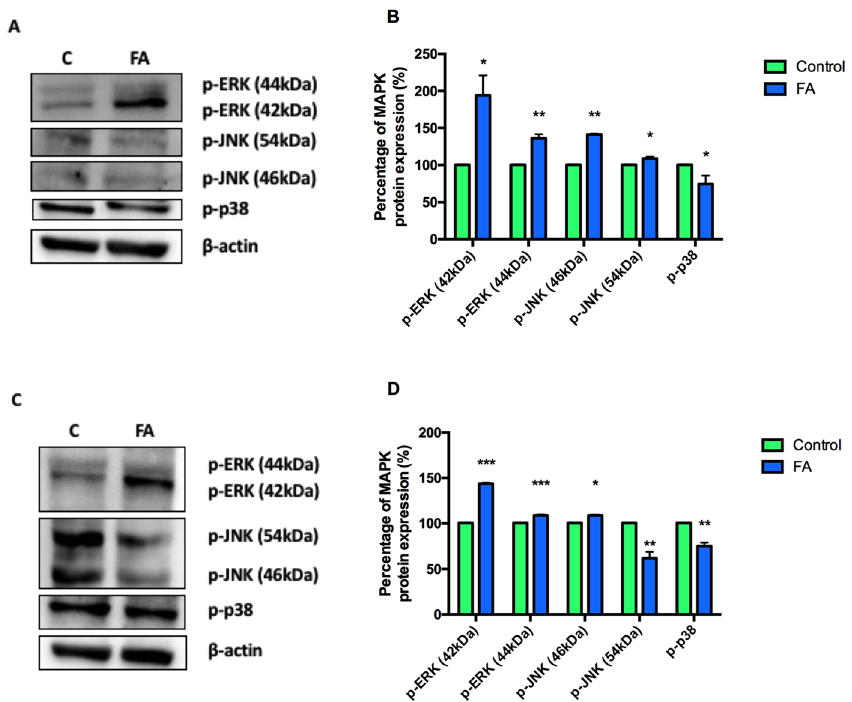
Figure 5. Effect of FA on MAPK protein expression. MAPK protein expression in healthy PBMCs ( A ) and Thp-1 cells ( C ). Percentage of MAPK protein expression in healthy PBMCs ( B ) and Thp-1 cells ( D ). Percentage of protein expressions were represented as mean ± SD. * p < 0.05 relative to respective control; ** p < 0.005 relative to respective control; *** p < 0.0001 relative to respective